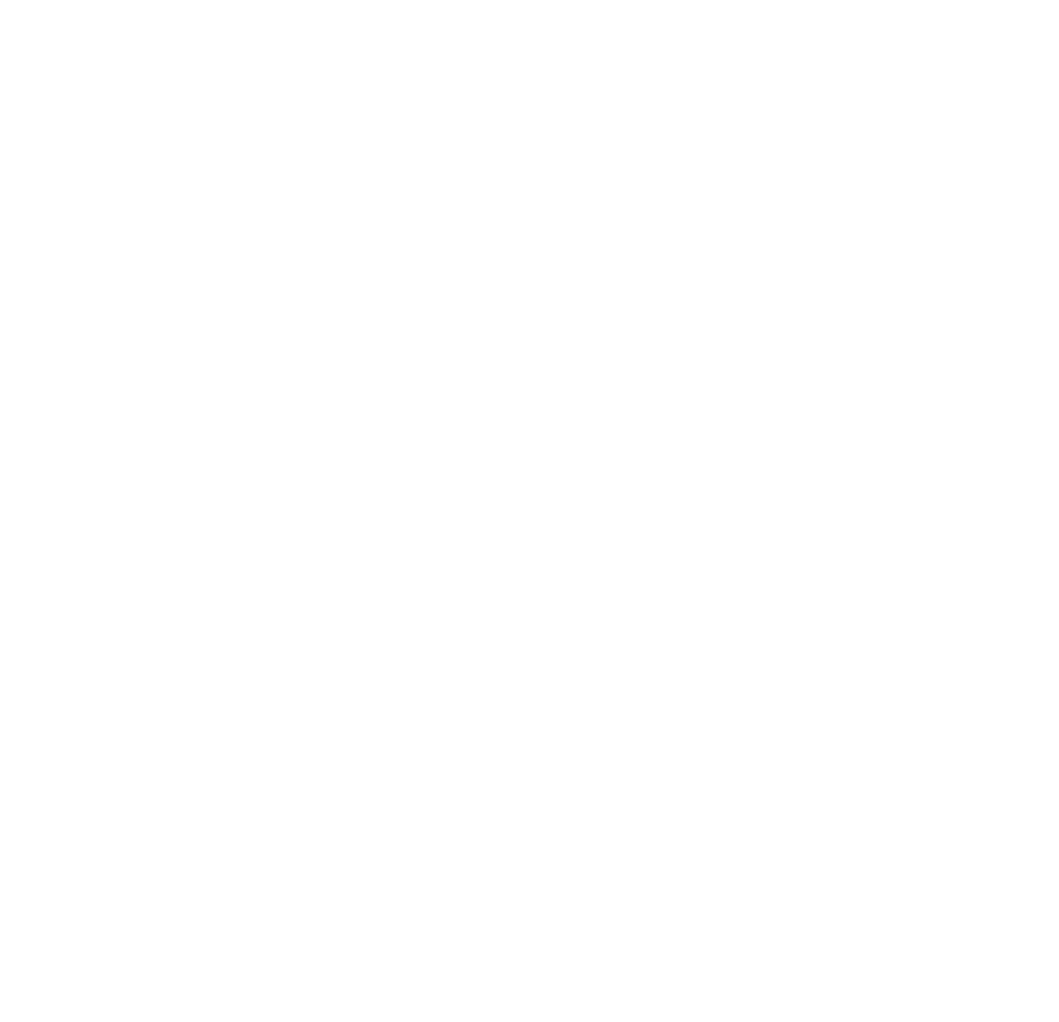
Cervical Cancer Awareness Measure Toolkit Version 2.1 Updated